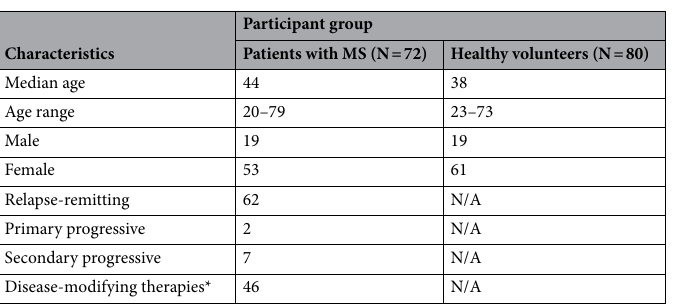
Table 1. Participant demographics. OS, Left eye; OD, Right eye. *These include: Fingolimod, Tecfidera, Dimethylfumerate, Copaxone, Plegridy, Alemtuzimab and Tysabri. One MS participant’s disease subtype was unable to be determined from their electronic